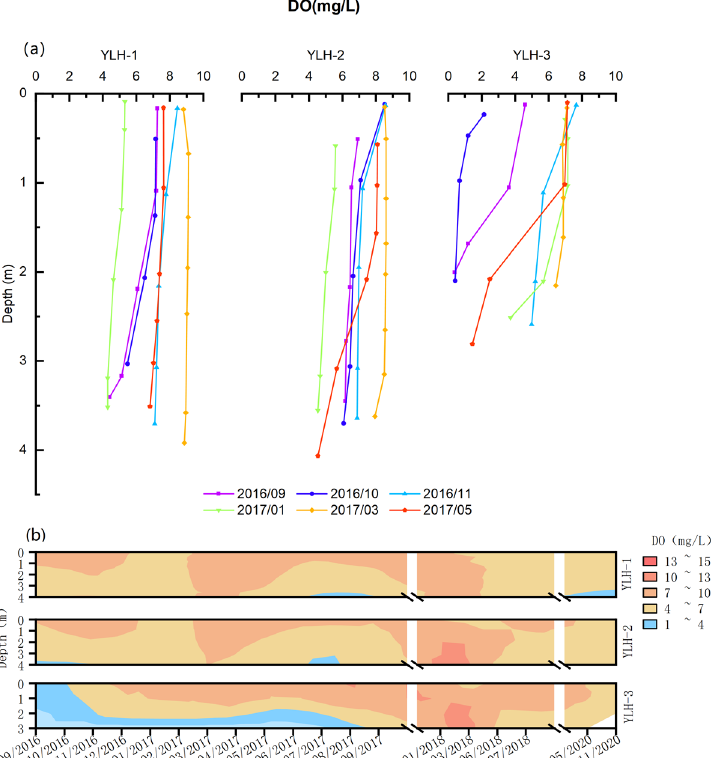
Figure 5. Seasonal and interannual variations in DO in lake Yilong. ( a ) Seasonal variations in water temperature; ( b ) Interannual variations in water temperature.